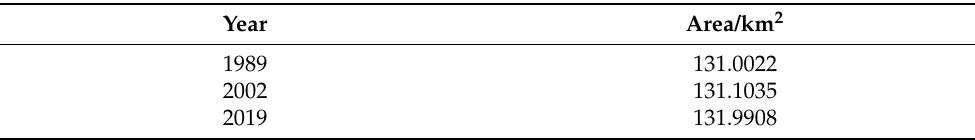
Table A1. The lake area during the high water period in 1989, 2002, and 2019.